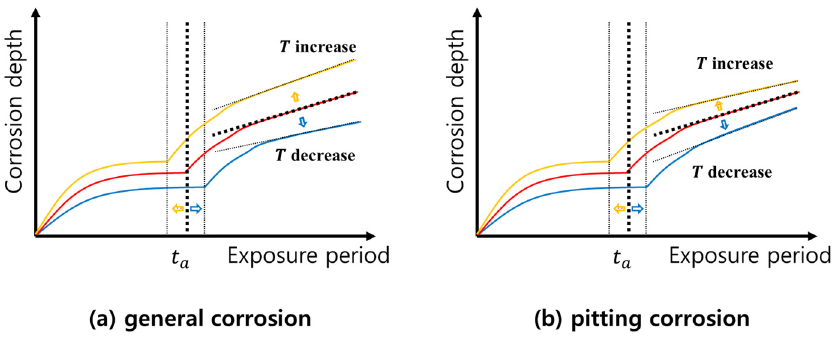
Figure 10. Corrosion depth change by temperature; ( a ) general corrosion; ( b ) pitting corrosion.